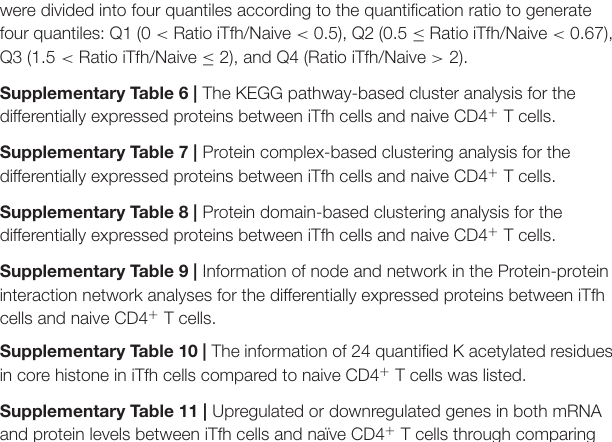
Supplementary Figure 4 | Protein complex and protein domains-based clustering analysis for the differentially expressed proteins between iTfh cells and naive CD4 + T cells. Supplementary Figure 5 | The representative spectrum of CREBBP (A) , XRCC5 (B) , and TCP1 (C) proteins that underwent increased or/and decreased acetylation in iTfh cells compared to naive CD4 + T cells. Supplementary Figure 6 | Enrichment and clustering analysis of the quantitative acetylome data sets in naive CD4 + T cells and iTfh cells based on the cellular compartment, molecular function, the KEGG pathway, and protein domains. All of the quantified acetylation proteins were also divided into four quantiles (Q1–Q4) according to Tfh/N ratios: Q1 (0 < Ratio T/N < 0.667), Q2 (0.667 < Ratio T/N < 0.77), Q3 (1.3 < Ratio T/N < 1.5), and Q4 (Ratio T/N > 1.5). Supplementary Figure 7 | The representative spectrum of H2AFZ (A) , HIST1H4A (B) , and HIST1H1B (C) proteins that underwent increased or/and decreased acetylation in iTfh cells compared to naive CD4 + T cells. Supplementary Table 1 | The upregulated proteins with more than 1.5-fold increase in iTfh cells compared to naive CD4 + T cells. Supplementary Table 2 | The downregulated proteins with less than 1.5-fold decrease in iTfh cells compared to naive CD4 + T cells. Supplementary Table 3 | GO distribution of upregulated proteins (iTfh vs. naive T cells). Supplementary Table 4 | GO distribution of downregulated proteins (iTfh vs. naive T cells). Supplementary Table 5 | GO enrichment-based cluster analysis for the differentially expressed proteins between iTfh cells and naive CD4 + T cells, which were divided into four quantiles according to the quantification ratio to generate four quantiles: Q1 (0 < Ratio iTfh/Naive < 0.5), Q2 (0.5 ≤ Ratio iTfh/Naive < 0.67), Supplementary Table 6 | The KEGG pathway-based cluster analysis for the differentially expressed proteins between iTfh cells and naive CD4 + T cells. Supplementary Table 7 | Protein complex-based clustering analysis for the differentially expressed proteins between iTfh cells and naive CD4 + T cells. Supplementary Table 8 | Protein domain-based clustering analysis for the differentially expressed proteins between iTfh cells and naive CD4 + T cells. Supplementary Table 9 | Information of node and network in the Protein-protein interaction network analyses for the differentially expressed proteins between iTfh cells and naive CD4 + T cells. Supplementary Table 10 | The information of 24 quantified K acetylated residues in core histone in iTfh cells compared to naive CD4 + T cells was listed. Supplementary Table 11 | Upregulated or downregulated genes in both mRNA and protein levels between iTfh cells and naïve CD4 + T cells through comparing the proteomics data with published transcriptomics